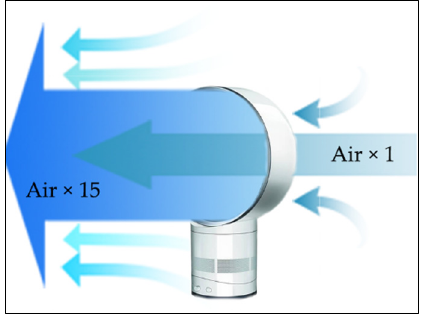
Figure 11. A bladeless fan.